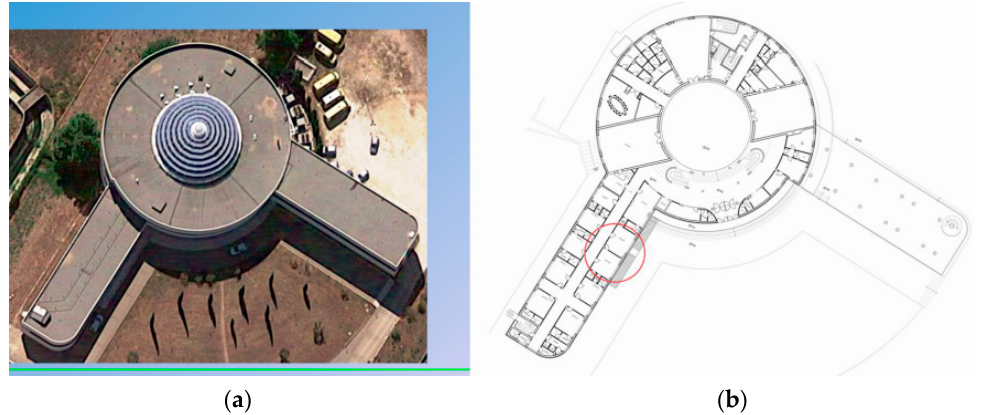
Figure 2. ( a ) Photo and ( b ) floor plan (right) of the building adopted for the testing of the protocol indicated in Figure 1 (Municipal building of the municipality of Nardò in the South of Italy). Experimentations were performed in the rooms indicated with the red circle.